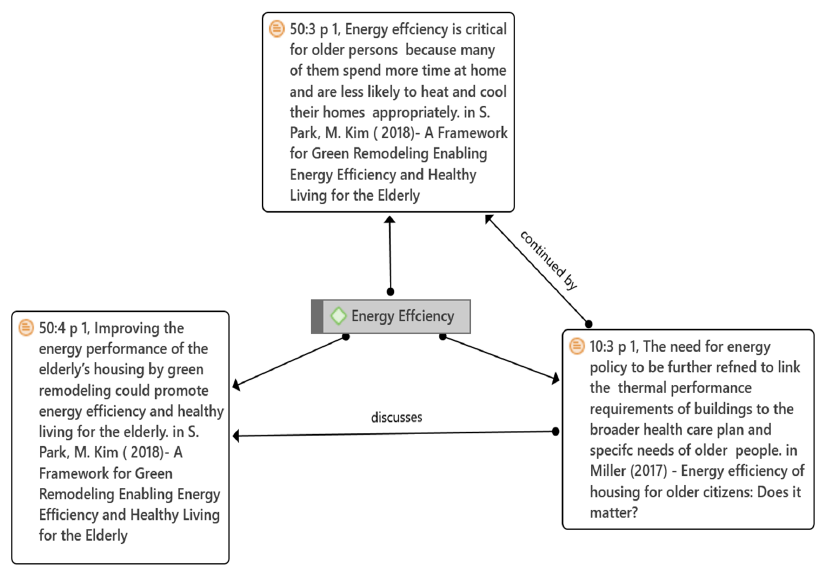
Figure 5. Energy e ffi ciency